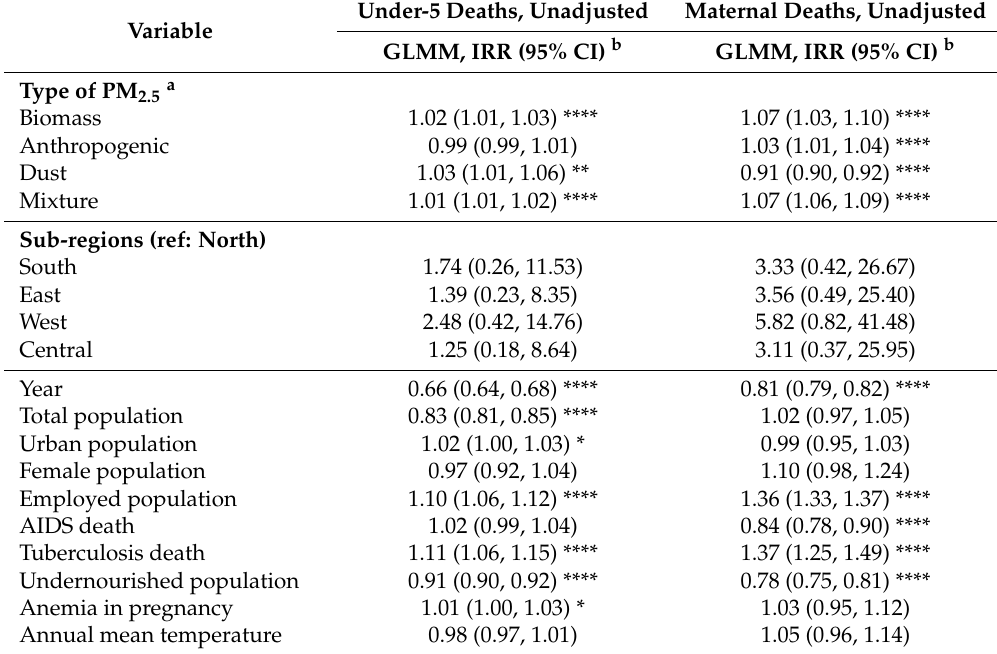
Table 2. Unadjusted incidence rate ratio (IRR) and 95% confidence interval (CI) of under-5 and maternal mortality in